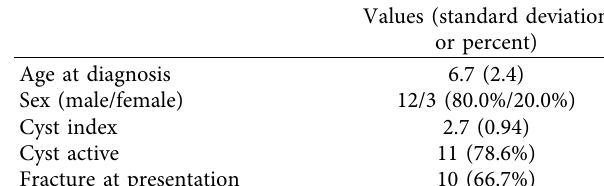
Table 1: Baseline characteristics.